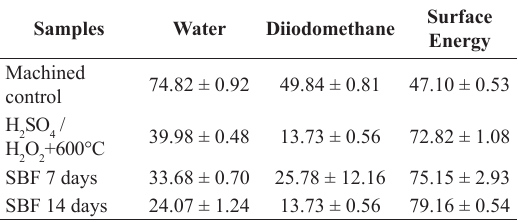
Table 1. Values of contact angle (°) and surface energy.